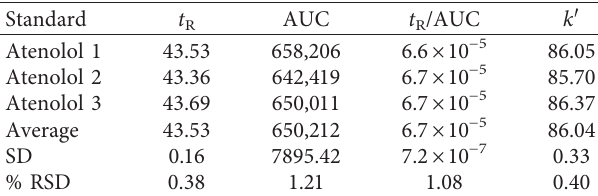
Table 12: Intracolumn reproducibility of MIP